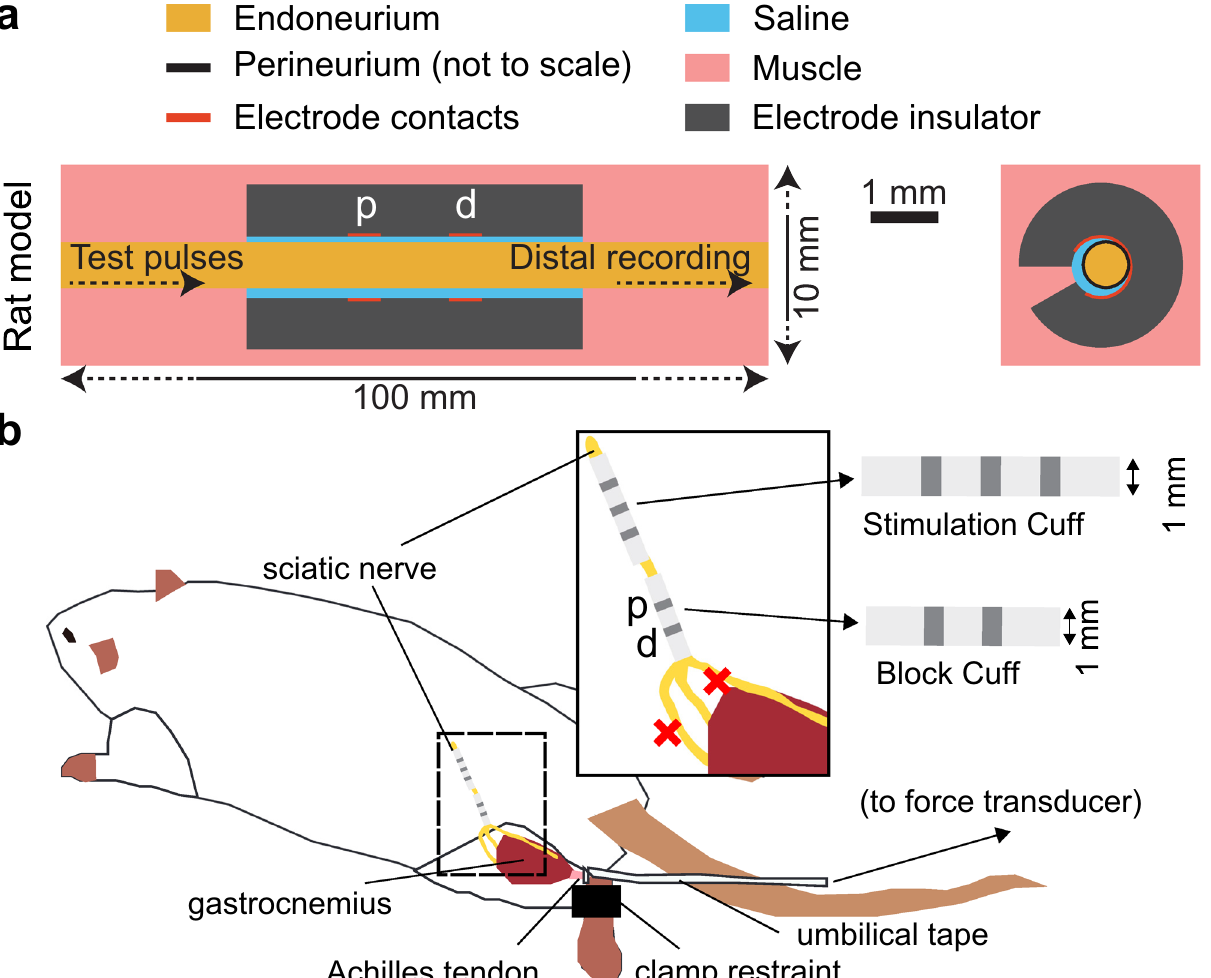
Figure 2. Finite element model of rat tibial nerve with bipolar cuff electrode ( a ), and analogous in vivo experimental setup targeting rat tibial nerve ( b ). The “p” and “d” labels indicate the proximal and distal contacts, respectively. In the computational model in panel ( a ), test pulses were evoked near the proximal end and the transmembrane potential was recorded near the distal end of each axon modeled within the endoneurium. In the in vivo setup in panel ( b ), the cuff electrodes were placed on the sciatic nerve; the common peroneal and sural branches were transected (red X’s), as well as the branches innervating the hamstring (not shown), and signals were transmitted to the gastrocnemius via the tibial